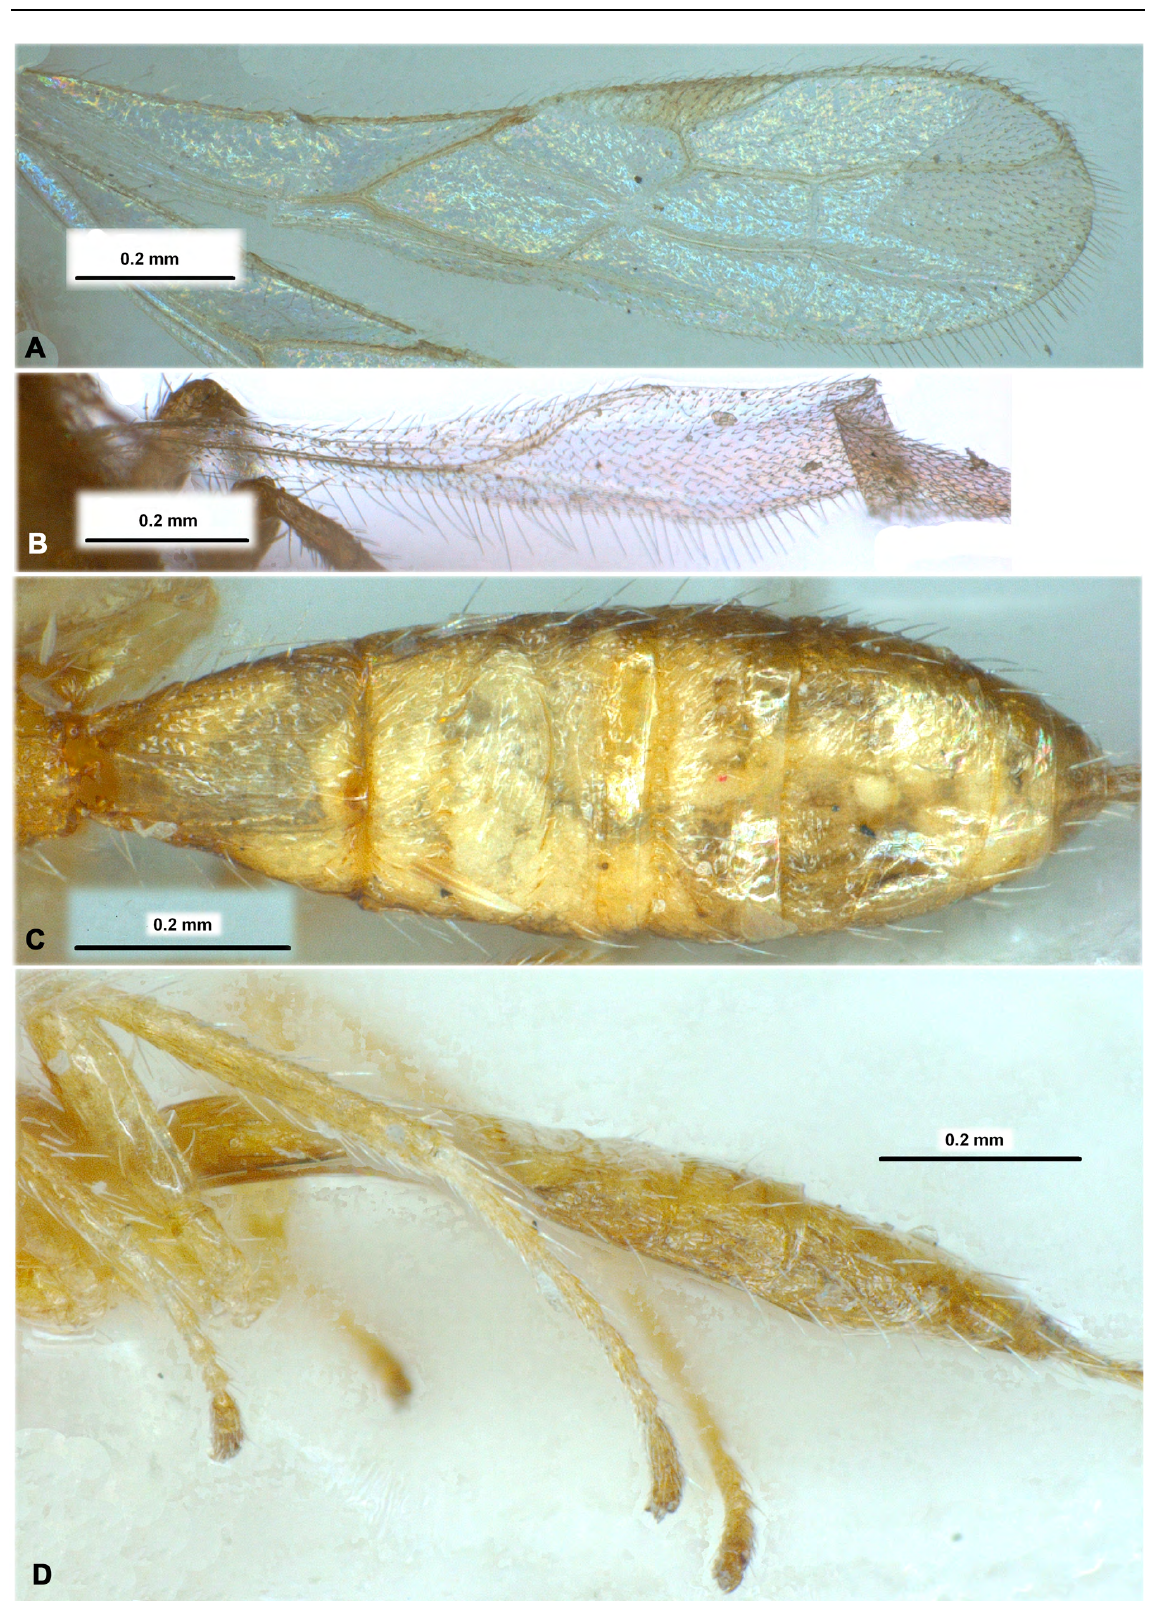
Fig. 41. Rhaconotinus caboverdensis Hedqvist, 1965, ♀, holotype, ZMHU. A . Fore wing. B . Hind wing, C . Metasoma, dorsal view. D . Metasoma and hind leg, lateral